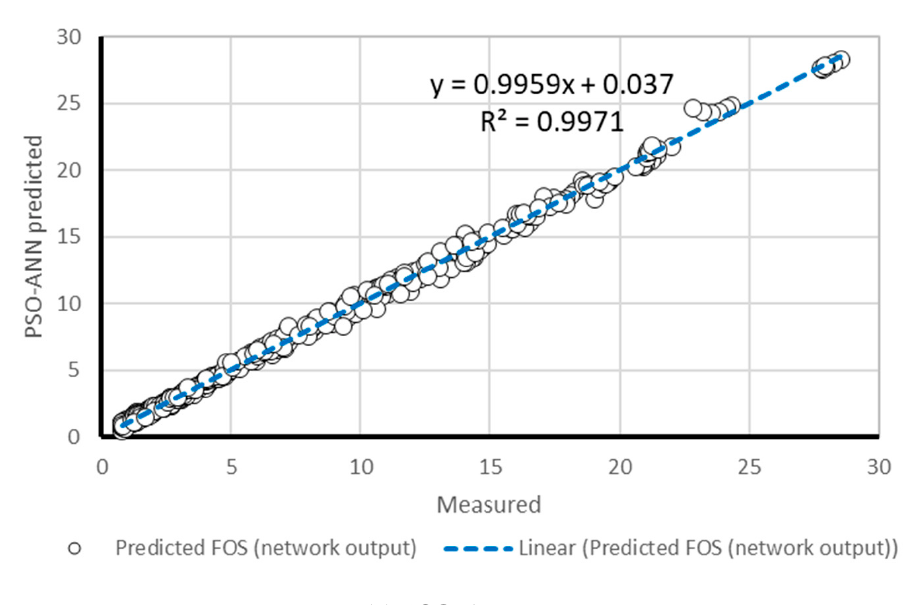
Figure 12. Training and testing outcomes of suggested approaches for predicting factor of safety for ( a ) ANN with six nodes, ( b ) ANFIS, and ( c ) PSO-ANN.